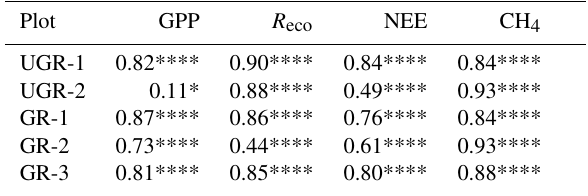
Table 2. R 2 and p values for linear regressions between fi- nal modeled fluxes and measured fluxes at ungrazed (UGR) and grazed (GR)